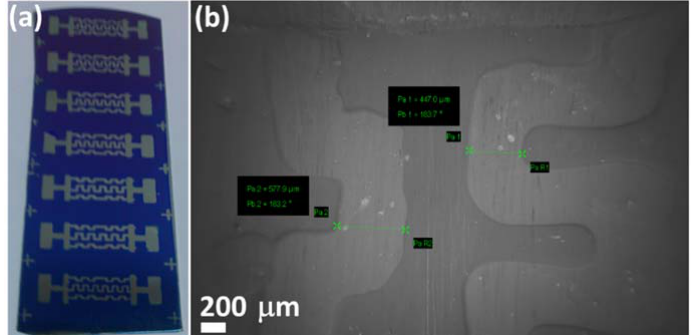
Figure 7. (a) Optical digital image; and (b) SEM image; of microheaters on ceramic substrate with nickel